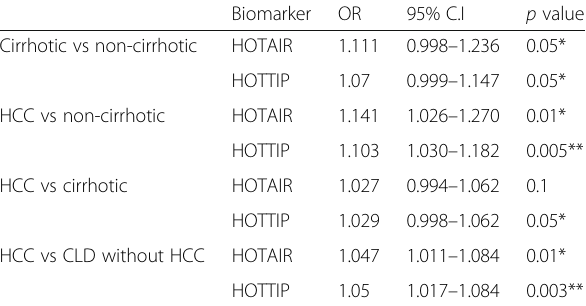
Table 7 Univariate analysis showing the predictive power of different biomarkers for cirrhosis and HCC diagnosis